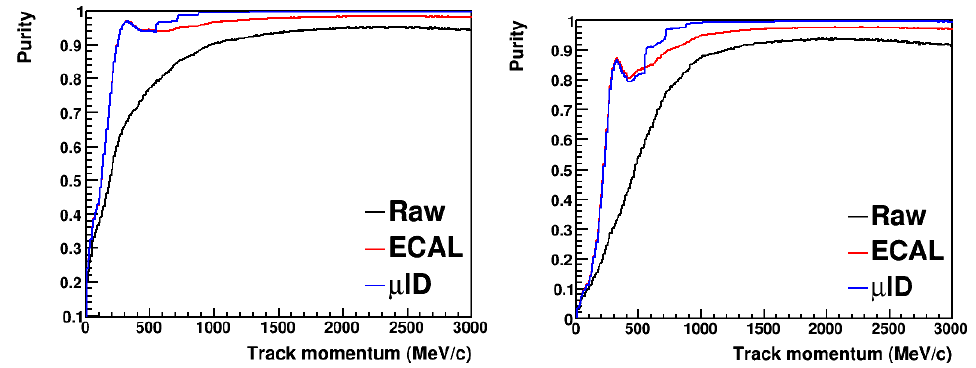
Figure 86. On the ( left ), the purity curve for the muon sample in FHC mode. On the ( right ), the purity curve for the muon sample in RHC mode.